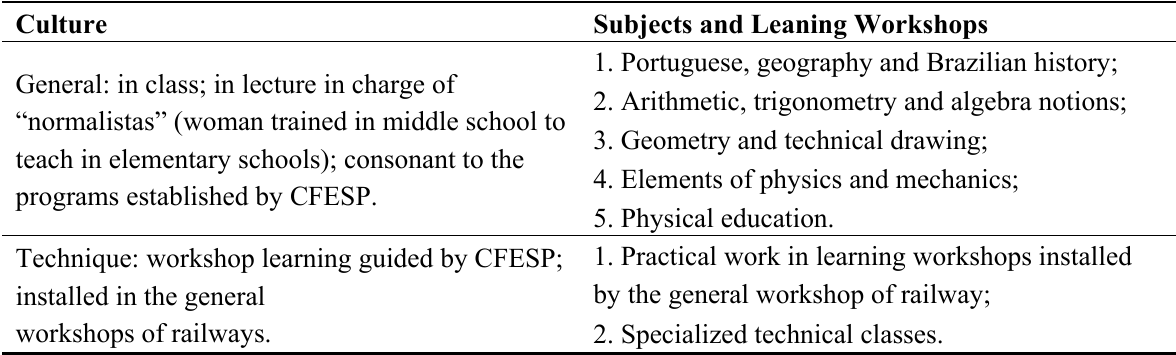
Table 1. Proposed curriculum for rail courses of CFESP